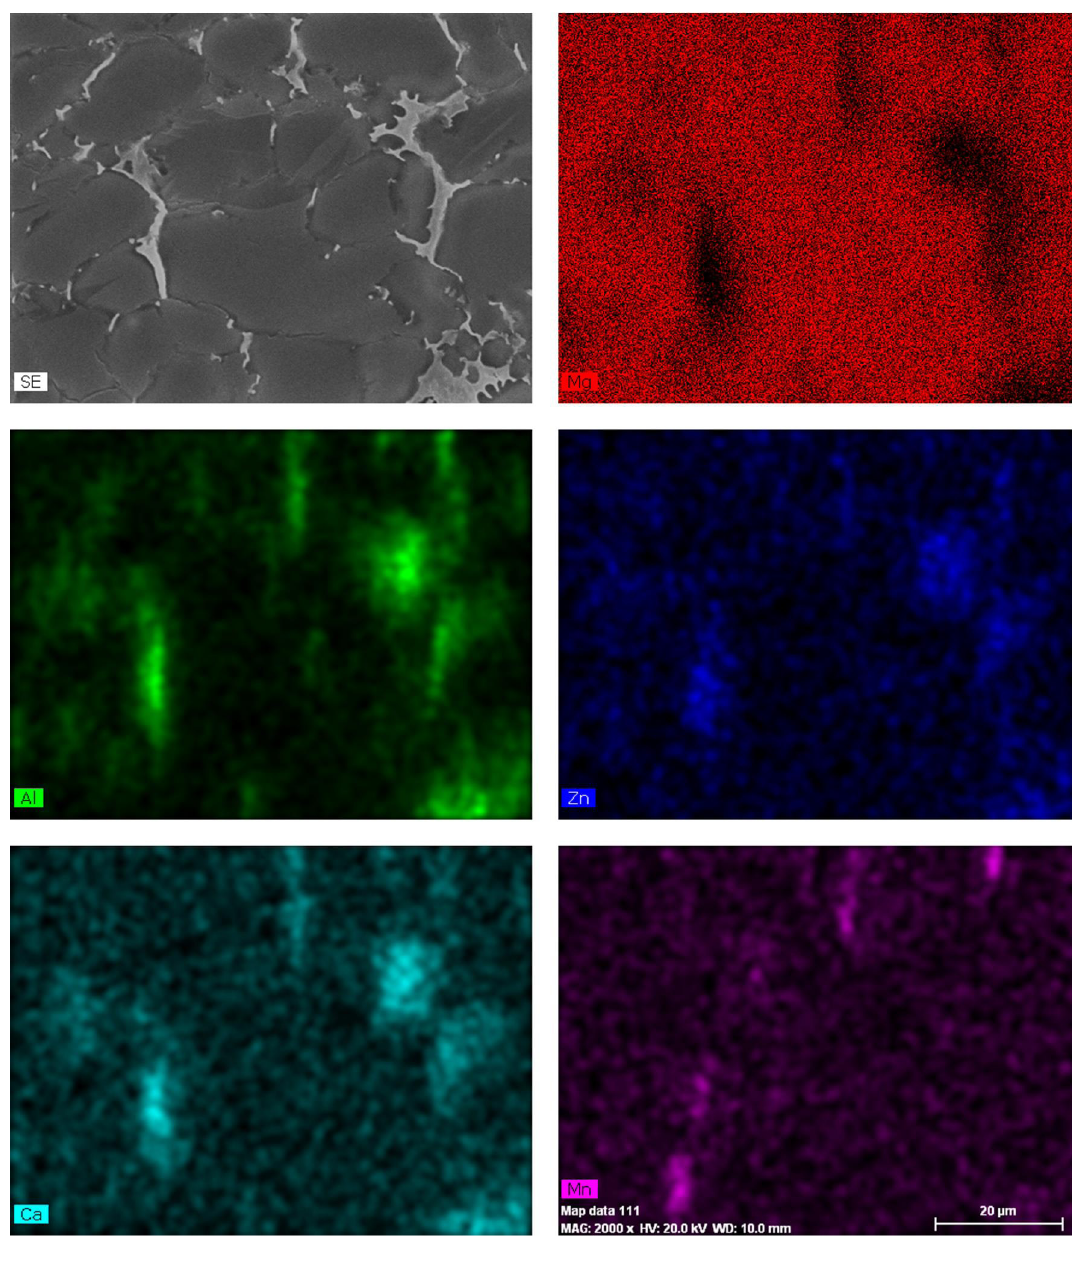
Fig. 2. SEM micrographs of specimens and X-ray mapping results for the TRC